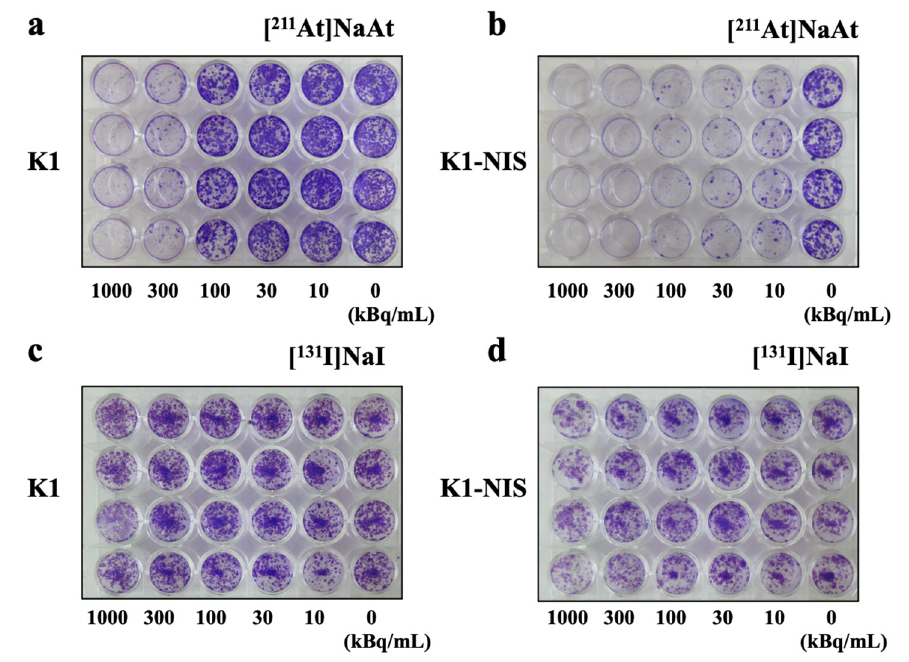
Figure 4. K1 or K1-NIS cell images after treatment with [ 211 I]NaAt ( a , b ) and [ 131 I]NaI ( c , d ) solutions stained with crystal